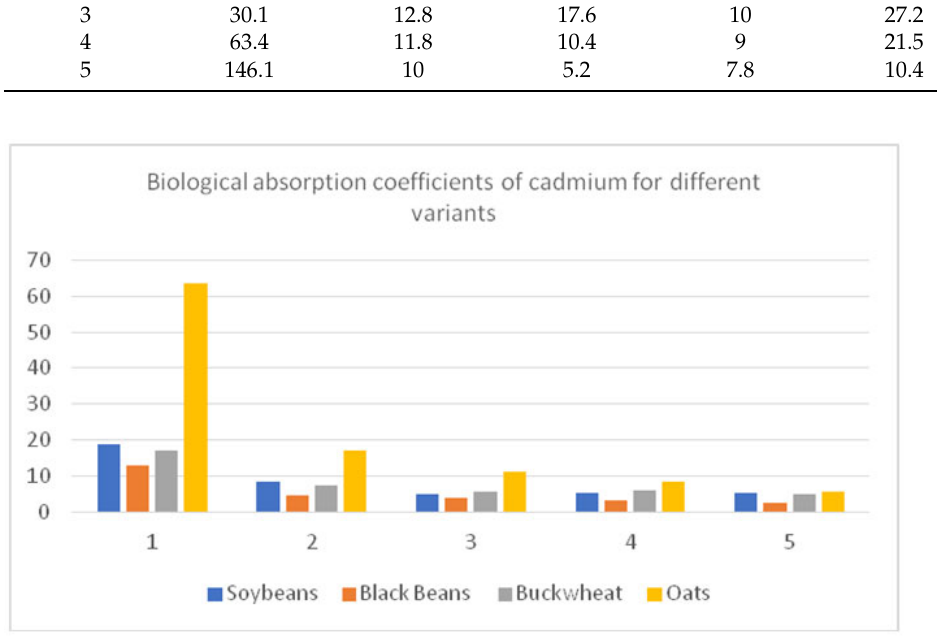
Figure 9. Values of the coefficients of biological absorption Ax (2) of cadmium at the different variants of the experiments (different total pollution index Zc ).